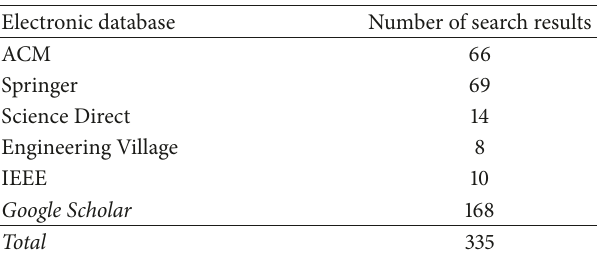
Table 1: Summary of electronic databases and number of search